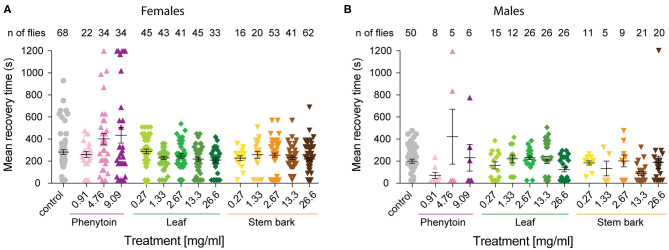
Mean recovery time for parabss flies treated with phenytoin and, leaf and stem bark A. senegalensis extracts. The time it took for each individual that showed a bang sensitive phenotype to complete recovery was calculated. Flies not seizuring were not included and if a fly was still seizuring at the end of the experiment its time was recorded as 1,200 s. Mean ± SEM is shown. (A) The MRT was significantly affected by the treatment in females (Kruskal-Wallis test H(14) = 30.21, p = 0.004). There were no differences between the control and other treatments as tested with a Dunn's post hoc test. (B) The MRT was significantly affected by the treatment in males (Kruskal-Wallis test H(14) = 31.04, p = 0.003). Dunn's post hoc test showed that the control was only different with the stem bark 13.3 mg.ml−1 treatment (p = 0.02). Number of males is lower because MRT measures the time to recovery of paralyzed flies, and fewer males than females where paralyzed at t = 0.